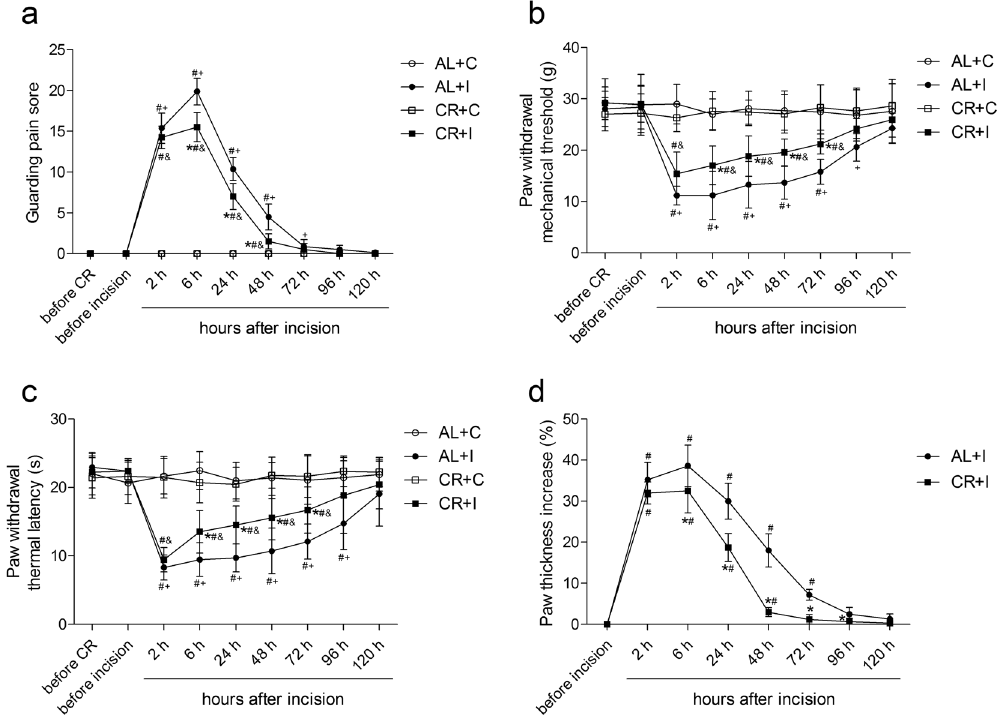
Figure 2. Caloric restriction attenuated nonevoked pain, mechanical allodynia, thermal hyperalgesia and hindpaw edema after surgical incision. ( a ) Caloric restriction attenuated incision-induced nonevoked pain presented as GPS of right hindpaw (n = 8). ( b ) Caloric restriction attenuated incision-induced mechanical allodynia presented as PWMT of right hindpaw (n = 8). ( c ) Caloric restriction attenuated incision-induced thermal hyperalgesia presented as PWTL of right hindpaw (n = 8). ( d ) Caloric restriction attenuated incision- induced right hindpaw edema presented as paw thickness increase (n = 8). Values expressed as mean ± SD. The treatment style was same as described in Fig. 1. Significant difference was revealed after two-way ANOVA ( * P < 0.05 in comparison of group CR + I with group AL + I, # P < 0.05 compared with baseline, + P < 0.05 compared with group AL + C, & p < 0.05 compared with group CR + C, Bonferroni post hoc